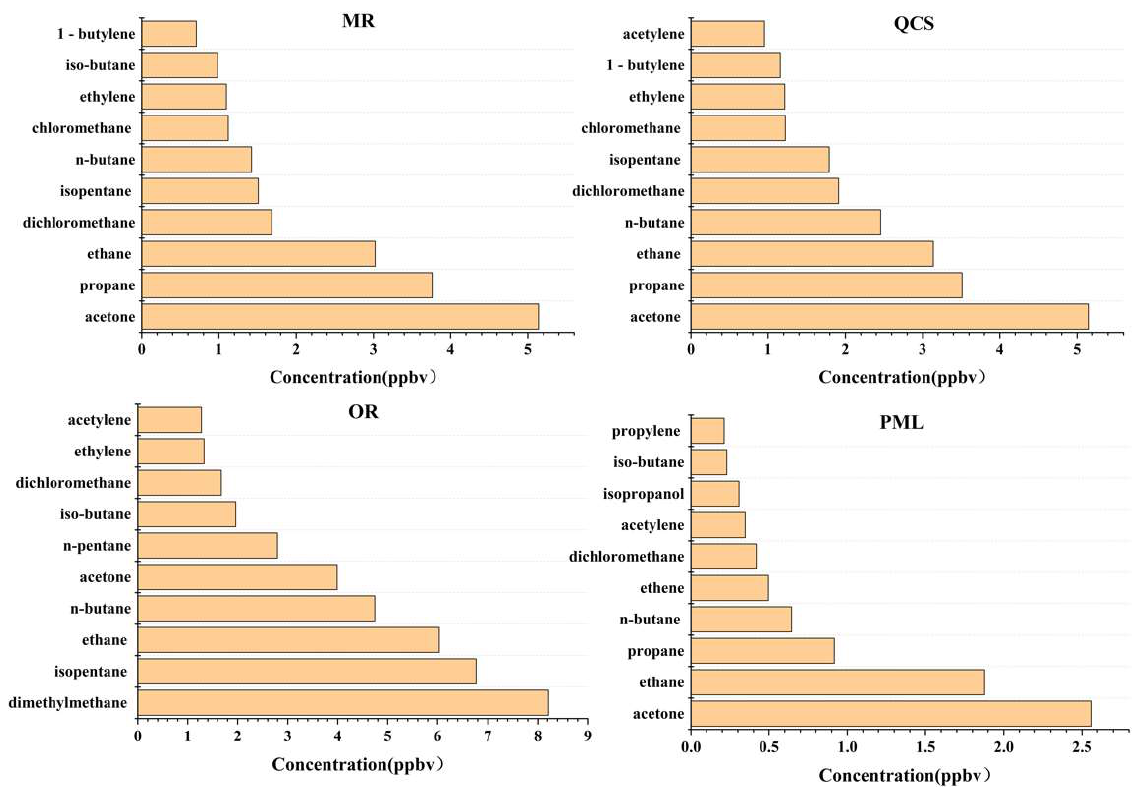
Figure 6. Top 10 volatile organic compounds by volume fraction at each site.